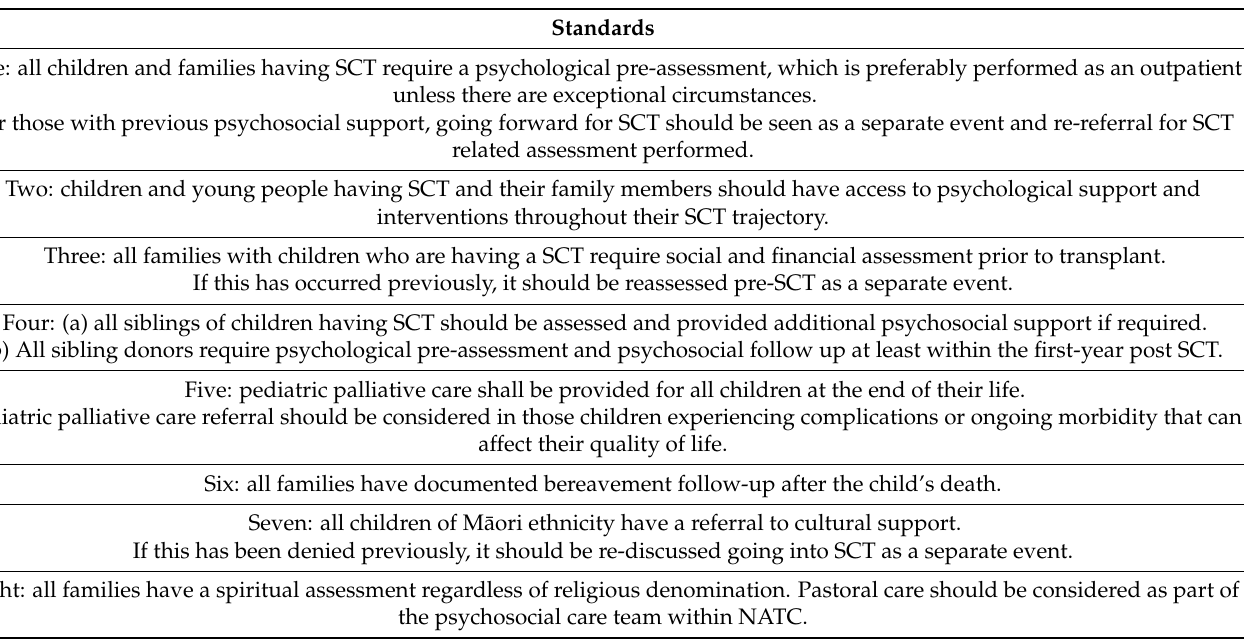
Table A1. Recommended SCT standards for the National Allogeneic Transplant Centre.